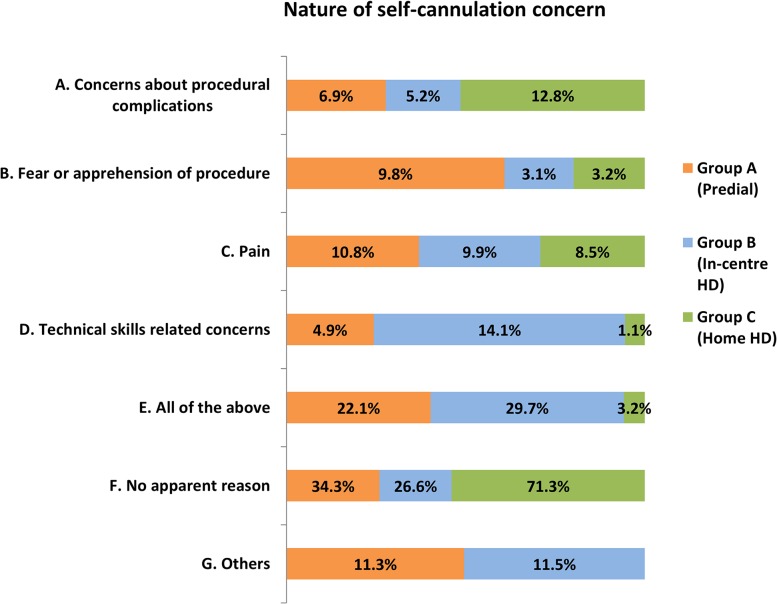
Bar chart depicting the nature of self-cannulation concern amongst patients in the three study groups.